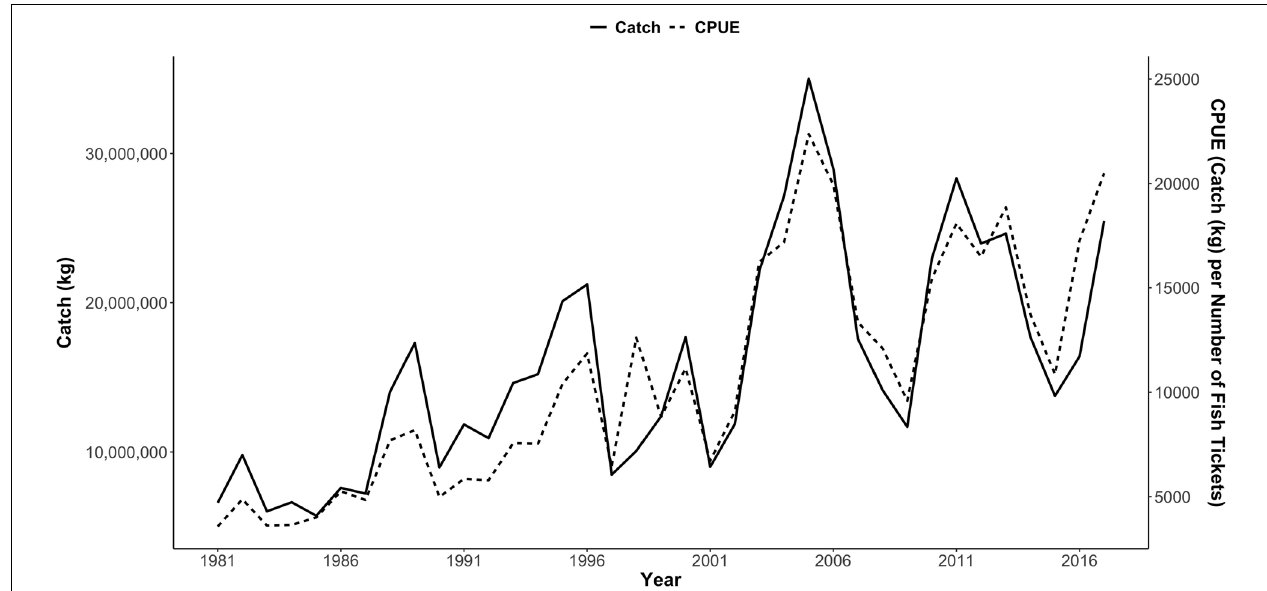
FIGURE 3 | Total commercial catch of Dungeness crab in kilograms (kg) per year (solid line) and catch per unit effort (dashed line) from 1981 to 2017 for the U.S. west coast, including 16 ports/regions in Washington, Oregon, and California. Catch per unit effort (CPUE) was calculated as kg caught per number of fish tickets per year. Data were provided by WDFW 2018, ODFW 2018, and CDFW 2018. Supplementary Figures S1–S4 show CPUE by port for each region.